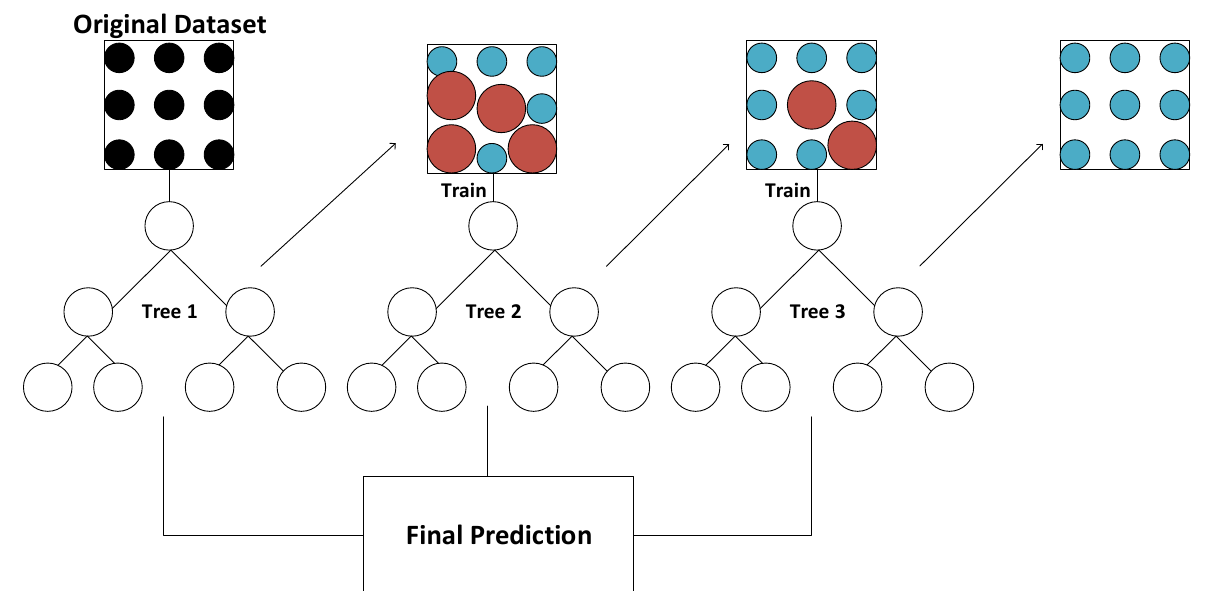
Figure 3. GBM diagram showing decision trees trained from the weighted, incorrect predictions.